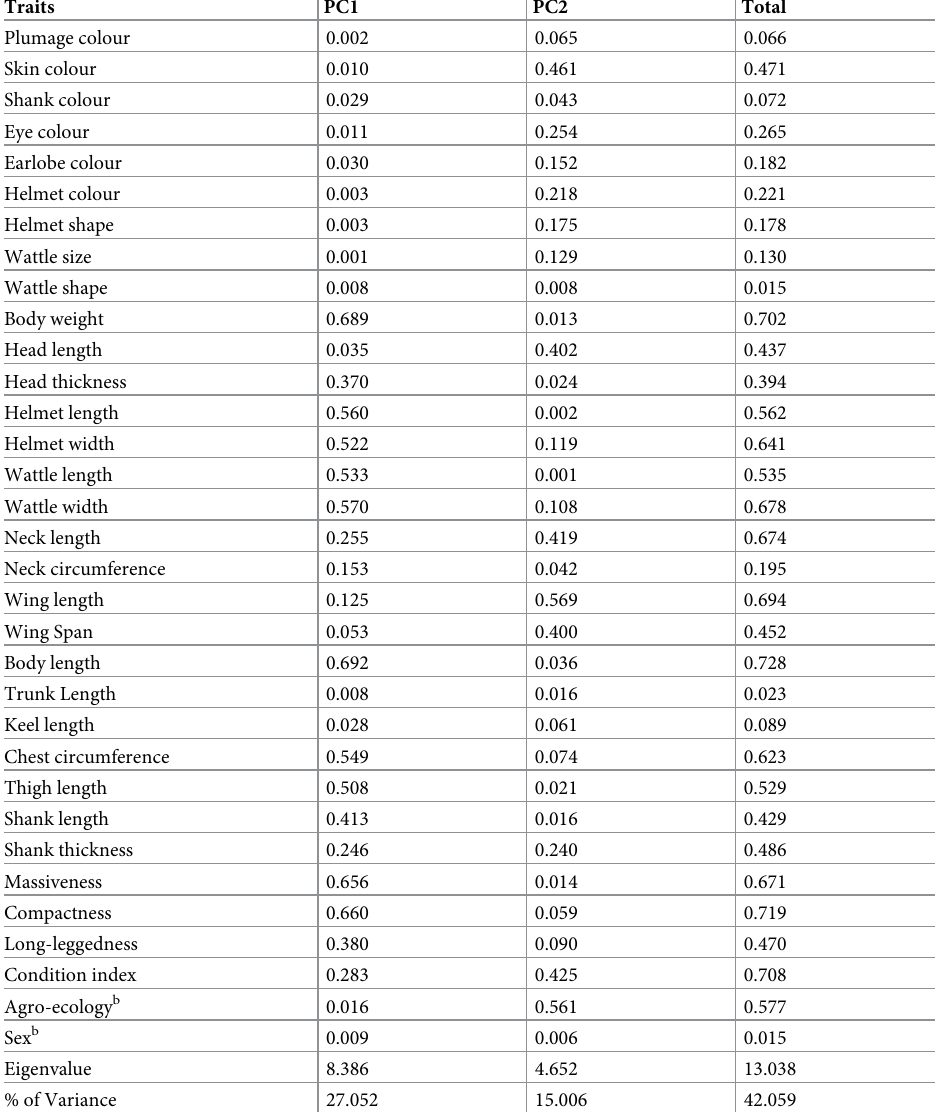
Table 8. Eigenvalue and the contribution of each qualitative and quantitative trait to the total variation in the principal components.